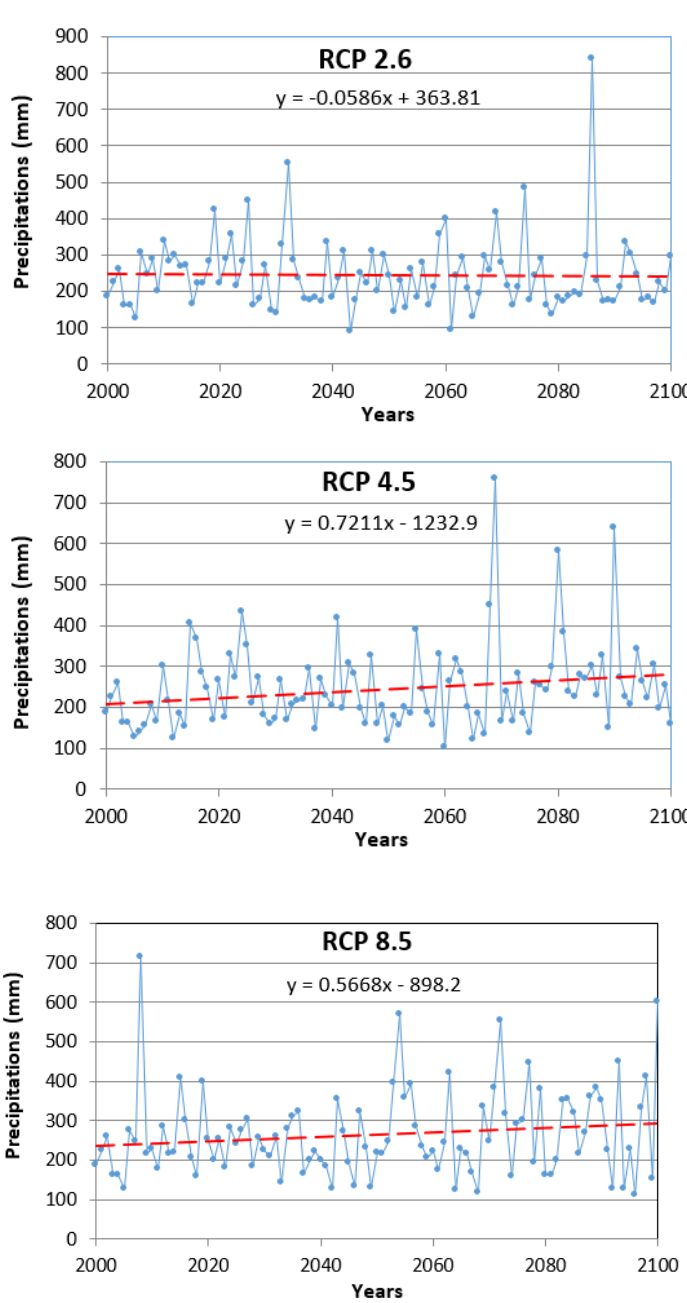
Figure 6. Results of the predictions of the three climate scenarios RCP 2.6, RCP 4.5 and RCP 8.5.